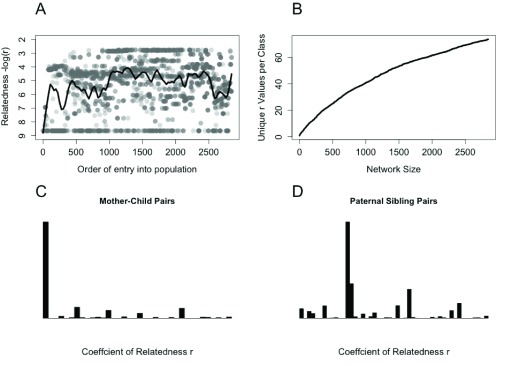
Effects of increasing network complexity on calculated coefficients of relatedness,
r, in the meerkat population.(
A) The mean coefficient of relatedness of focal individuals to the rest of the population is dependent on the order in which they enter the genealogy (either through birth or immigration) and is driven by changes in network connectedness and complex edge effects. (
B) Individuals become increasingly connected by multiple relatedness paths as the diameter of the kinship network grows, increasing the number of unique values of
r within each kinship category. (
C) For instance,
r between mother-child pairs increase from a single value (
r=0.5) to 38 unique values as the kDAG increases in size. (
D) A similar increase in unique
r values occurs between paternal sibling pairs. Traditional kinship categories do not capture this variation in relatedness coefficients within the pedigree.